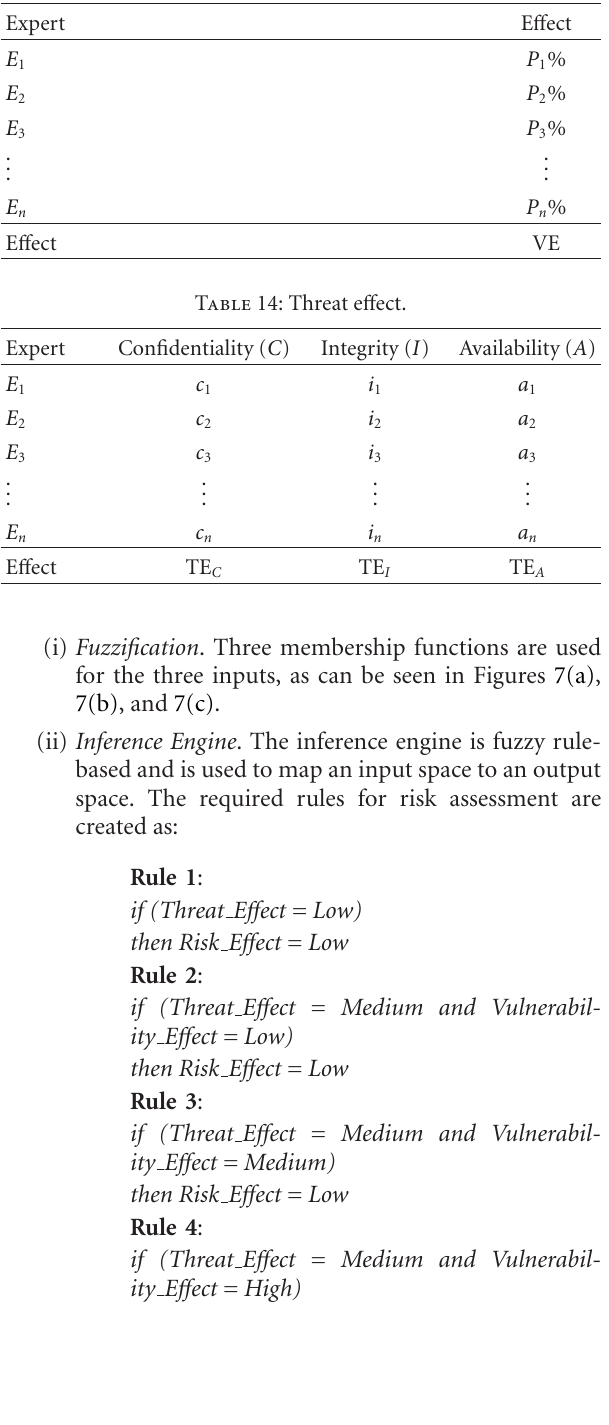
Table 13: Vulnerability E ff ect.